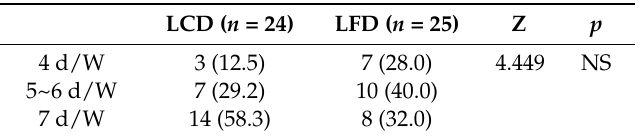
Table 2. Comparison of dietary adherence between the two